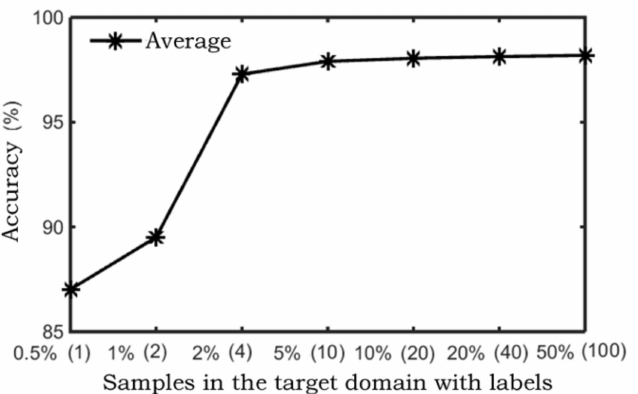
Figure 10. The average accuracy under a different number of labeled samples in the target domain.